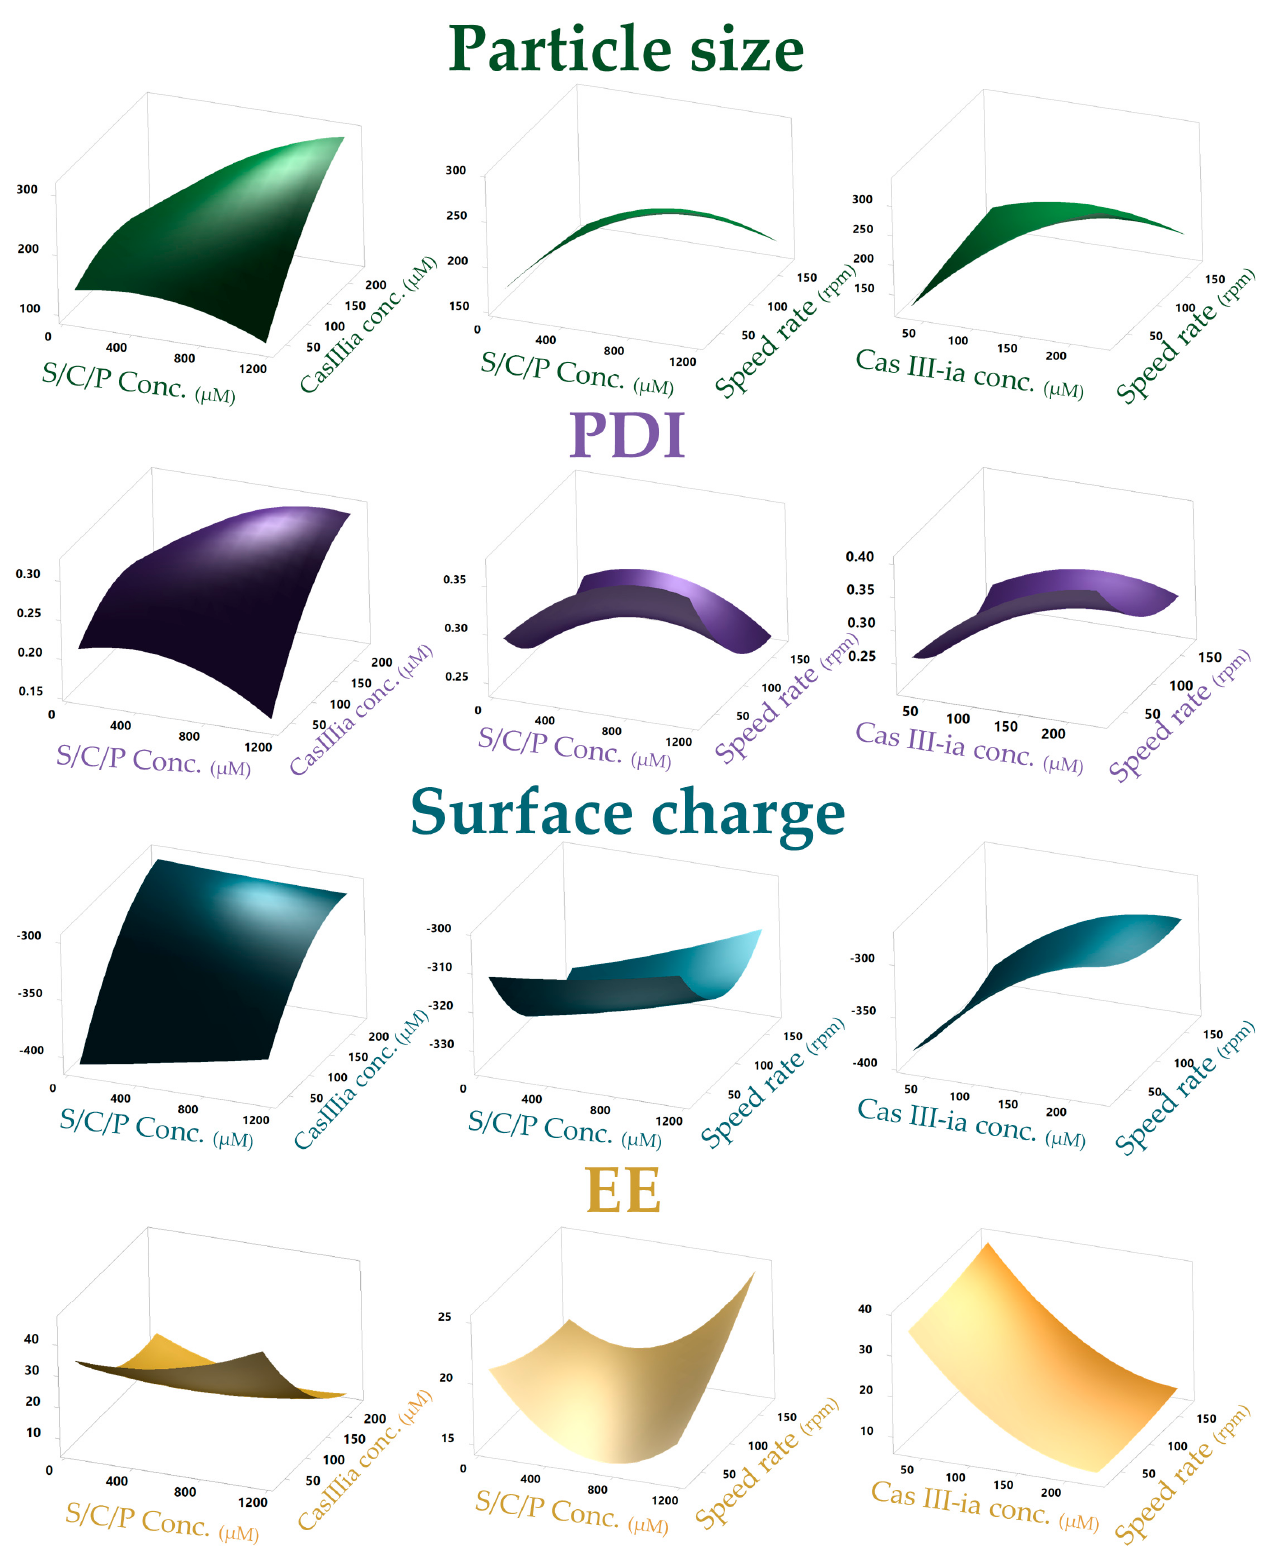
Figure 2. A 3D—response surface plot portraying the effect of the input variables on particle size, PDI, encapsulation efficiency, and surface charge.